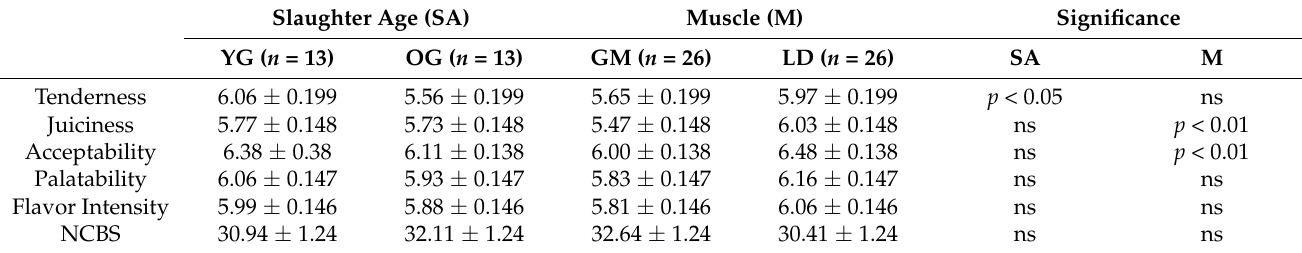
Table 2. Sensory panel scores and number of chews before swallowing of LD and GM muscles of the Holstein Friesian bulls expressed as least squares means ± standard